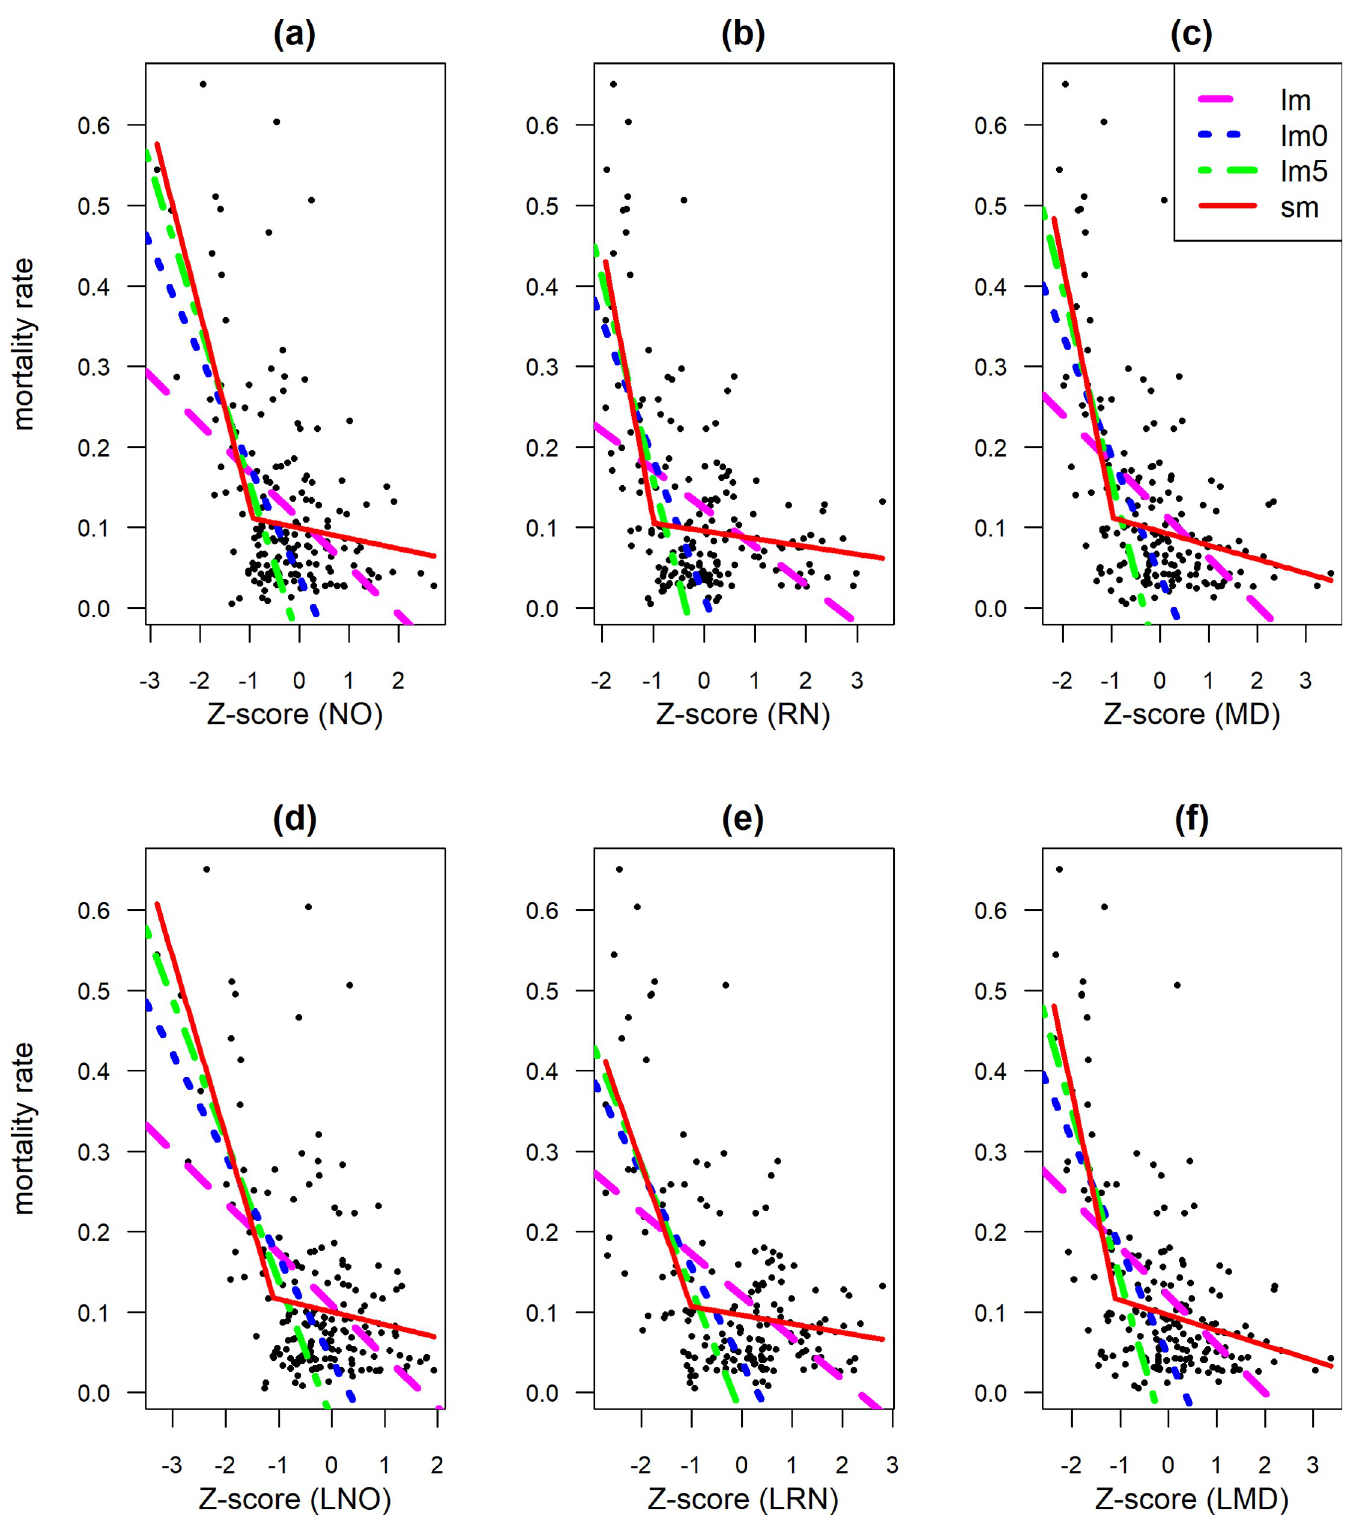
Fig 3. Livestock mortality in response to z -scores of (a) NOAA NDVI, (b) log(NOAA NDVI), (c) rainfall, (d) log(rainfall), (e) MODIS NDVI, and (f) log(MODIS NDVI) using linear regression (lm), piecewise linear regression when z -scores are less than zero (lm0) and -0.5 (lm5), and segmented regression (sm). Each observation corresponds to either the long or the short season of a sub-location in